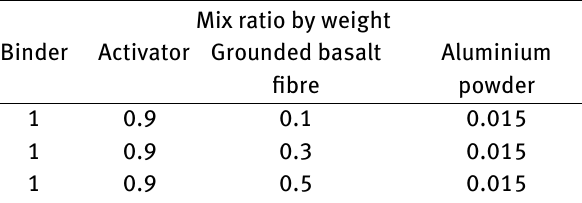
Table 2: Composition of geopolymer